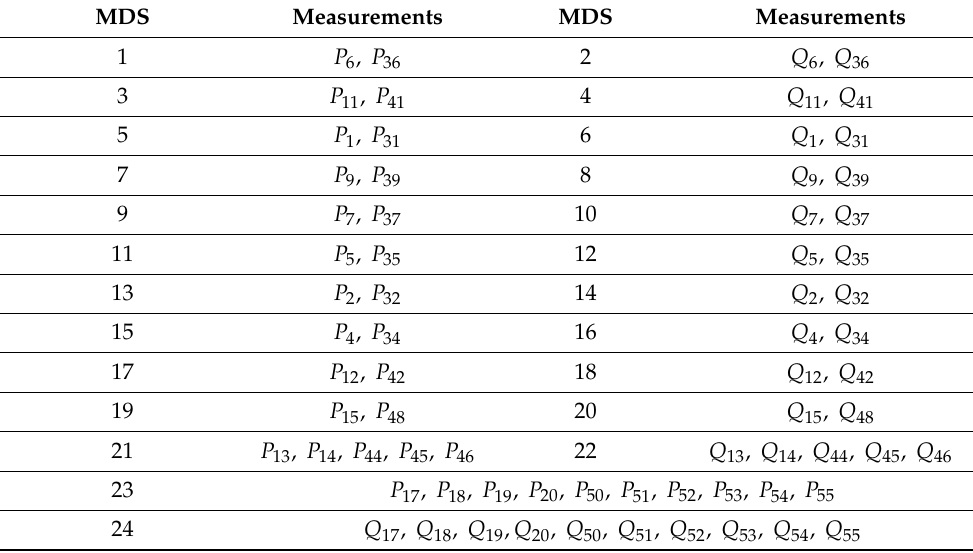
Table 4. Minimally dependent sets. MDS Measurements MDS